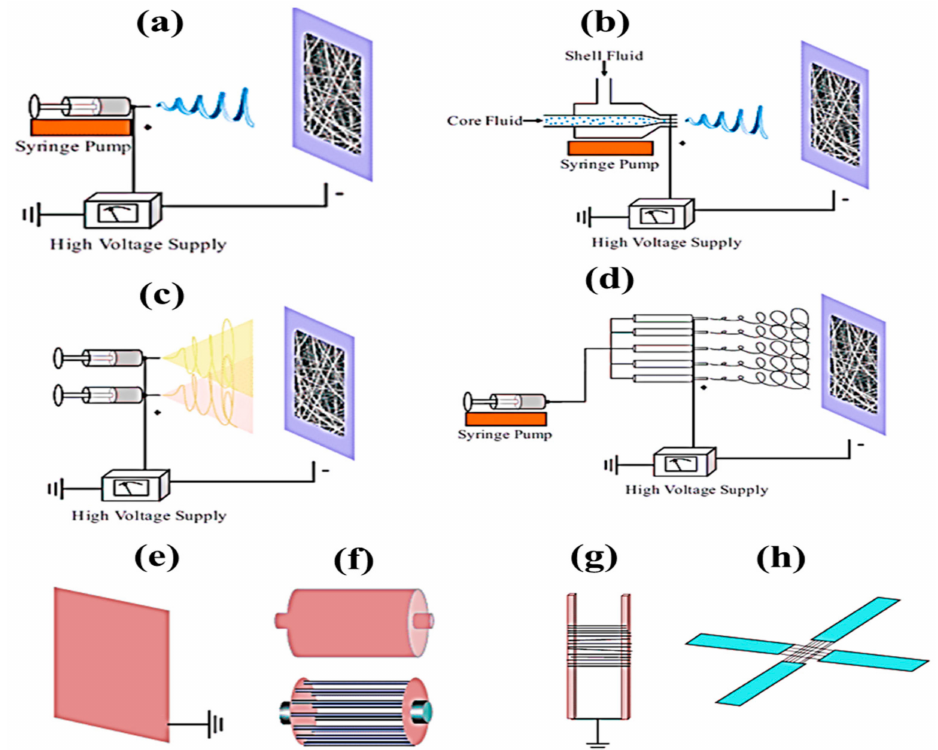
Figure 1. Different types of electrospinning, ( a ) basic, ( b ) co-axial, ( c ) side-by-side, ( d ) multiple-jet, and various types of collector, ( e ) metallic plate, ( d ) drum, ( f ) parallel electrode and ( h ) array of counter electrodes